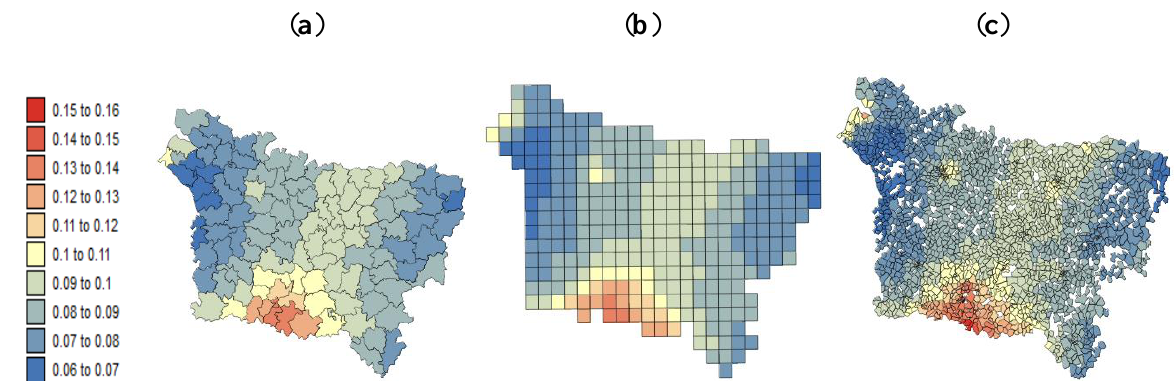
Figure 6. Maps of the exposure inhalation indicator (F1) aggregated at: ( a ) county level; ( b ) grid level; ( c ) IRIS level.